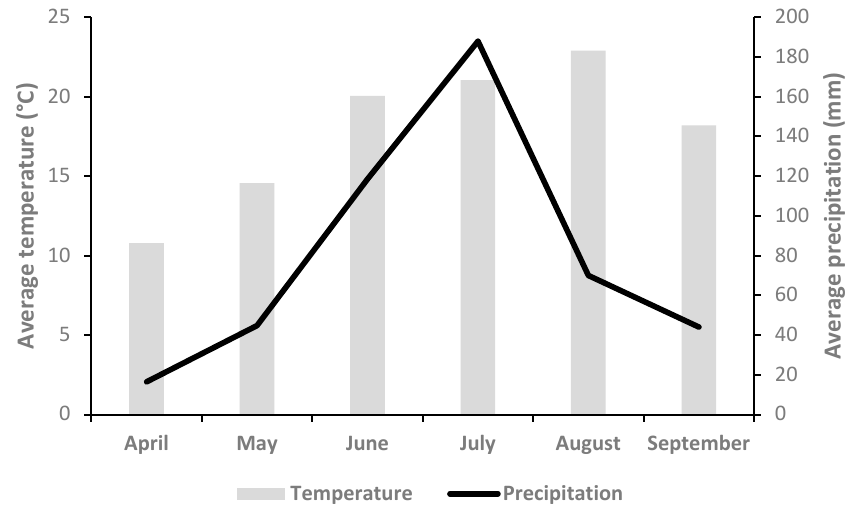
Figure 12. Precipitation and temperature data of the growing season (April 2020 and September 2020) in the experimental site.